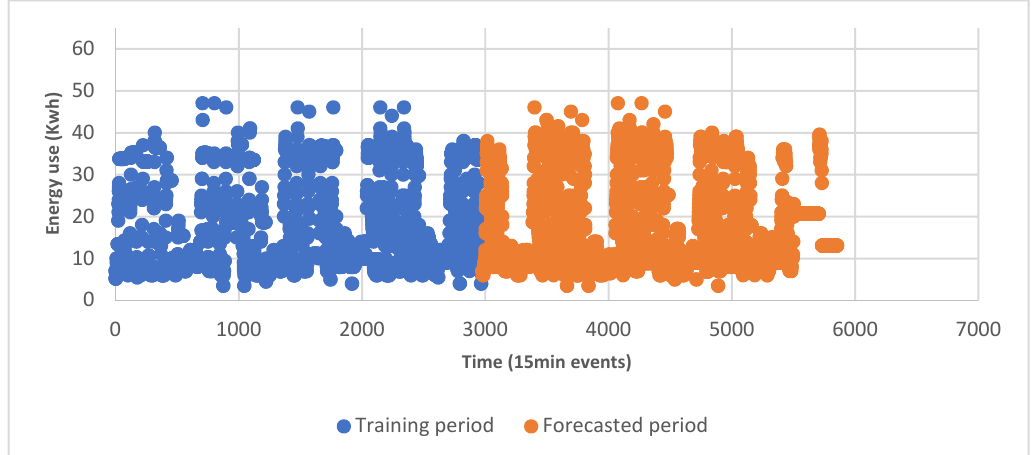
Figure A3. Building energy use over the autumn training and testing period.